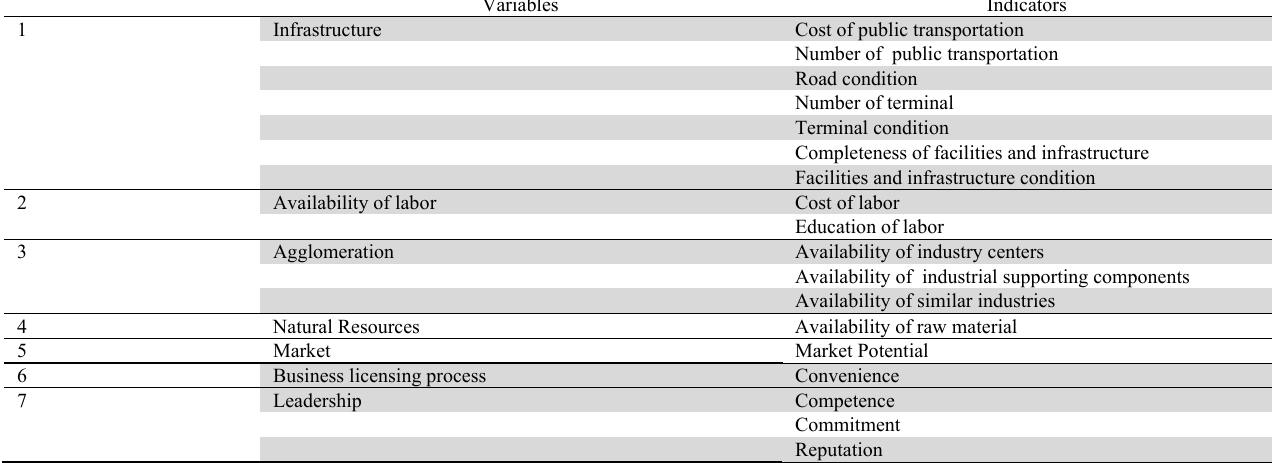
Variables and Indicators of